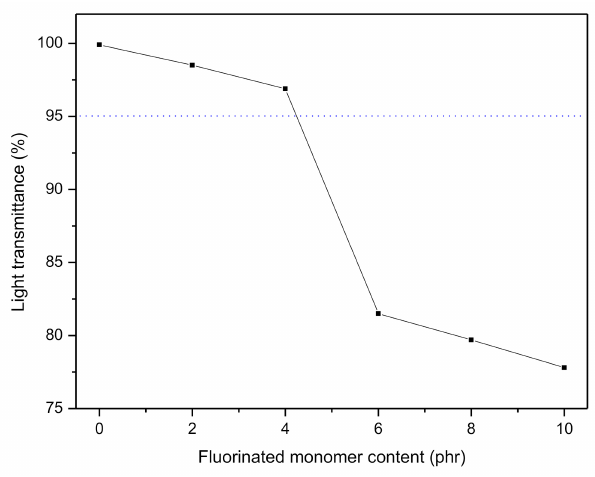
Figure 9. Light transmittance of the UV-LED curable coating at 550